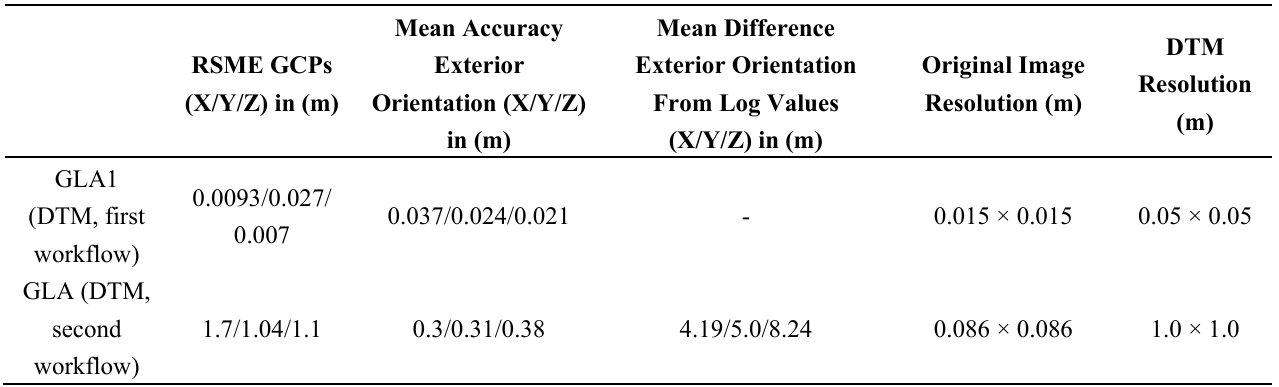
Table 3. Triangulation accuracy and resolution values of presented